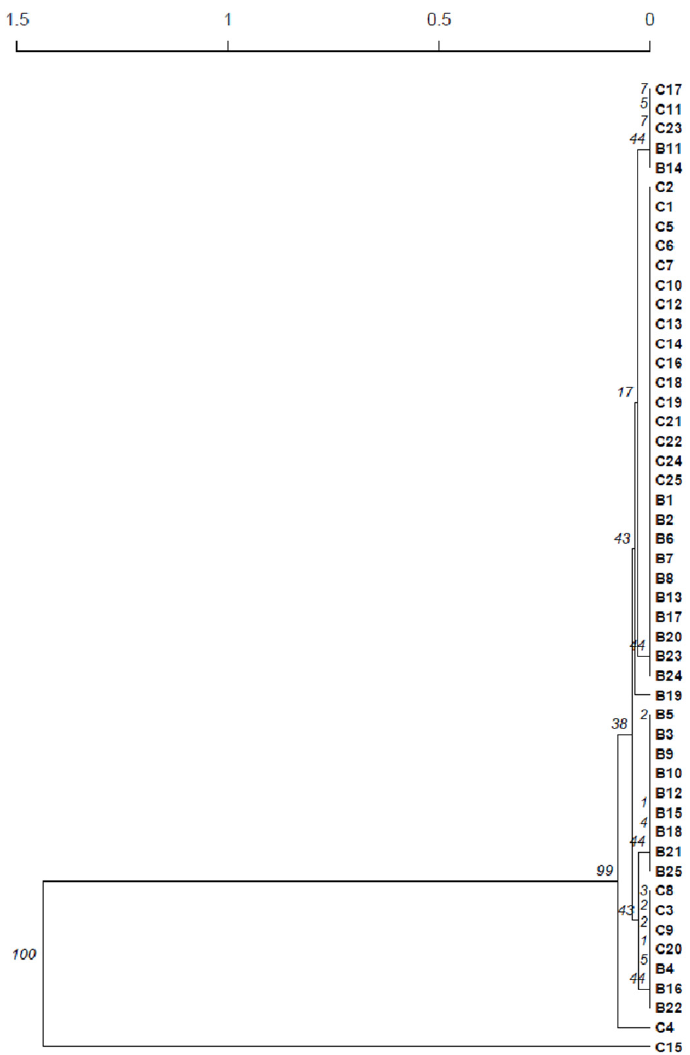
Figure 2. Dendrogram presenting the genetic distance between the ADY used in experiment 1, based on the microsatellite profiles. C—ADY C isolates; B—ADY B isolates; both are followed by the number of the isolate. Scale at top represents genetic distance.